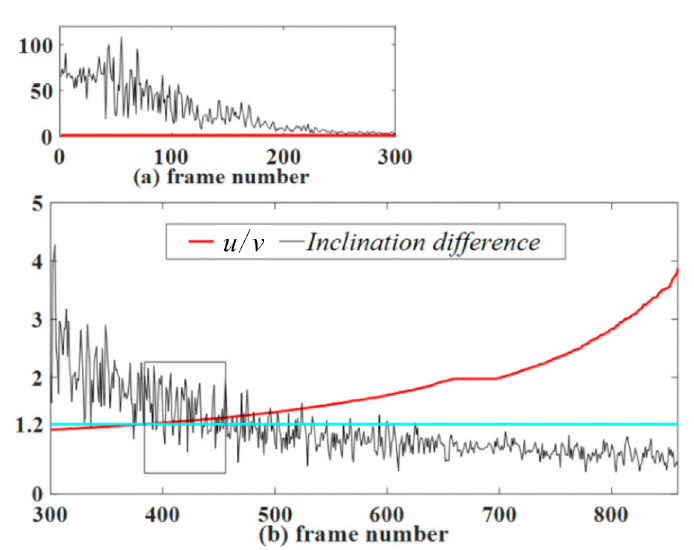
Figure 7. The relationship between this inclination difference ∆ ϕ and u / v . The parameter u is the semi-major axis of the outer ellipse. The parameter v is the semi-minor axis of the outer ellipse.